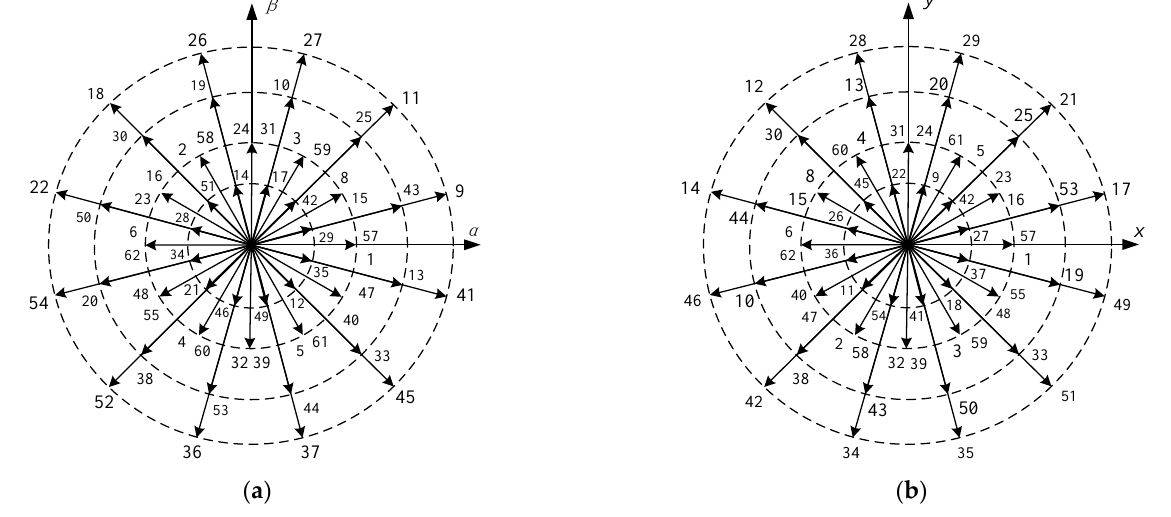
Figure 7. Dual three-phase motor space voltage vector distribution diagram. ( a ) Space voltage vector diagram of the fundamental subspace. ( b ) Space voltage vector diagram of the harmonic subspace.